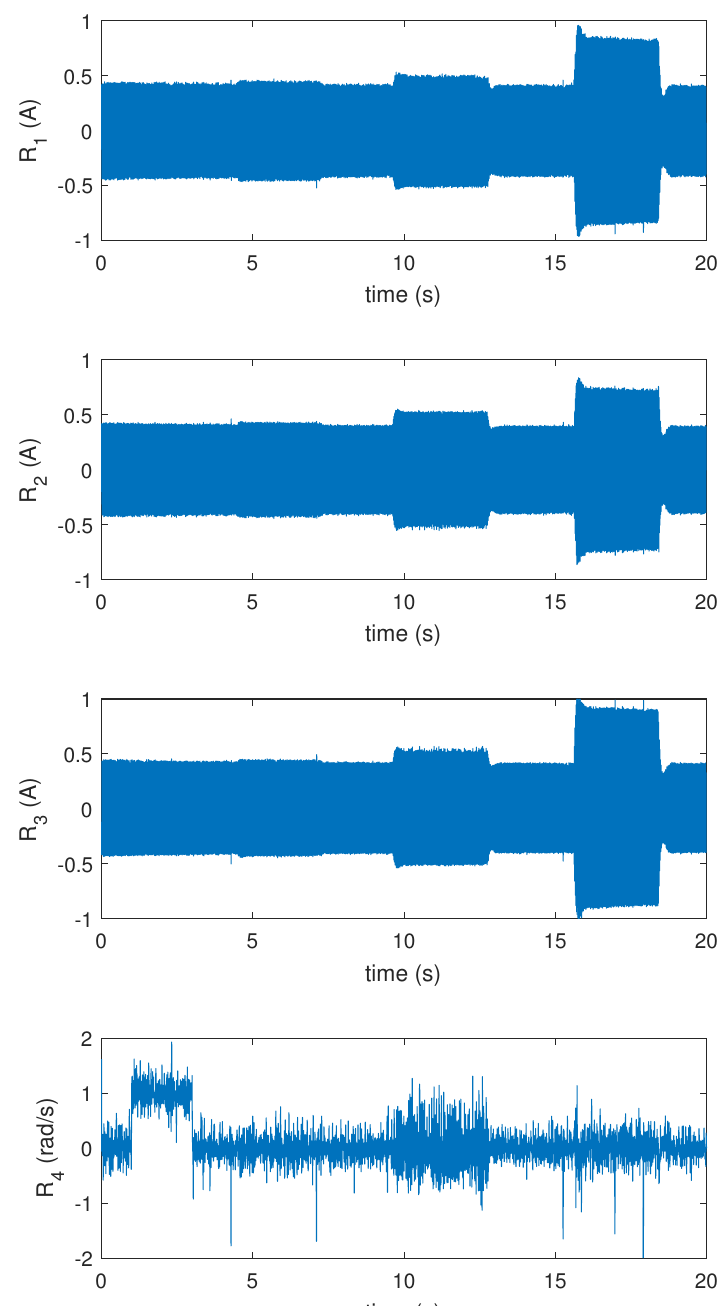
Figure 10. Residual responses in abc